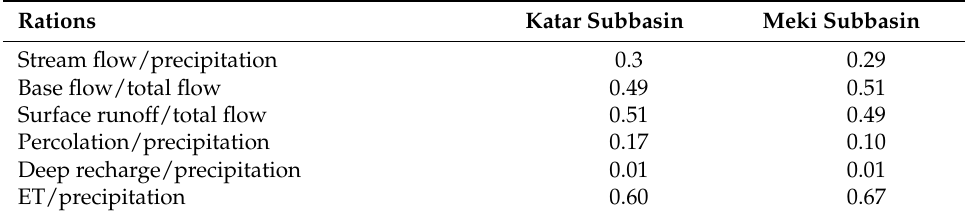
Table 6. Water balance ratio of Katar and Meki subbasins.